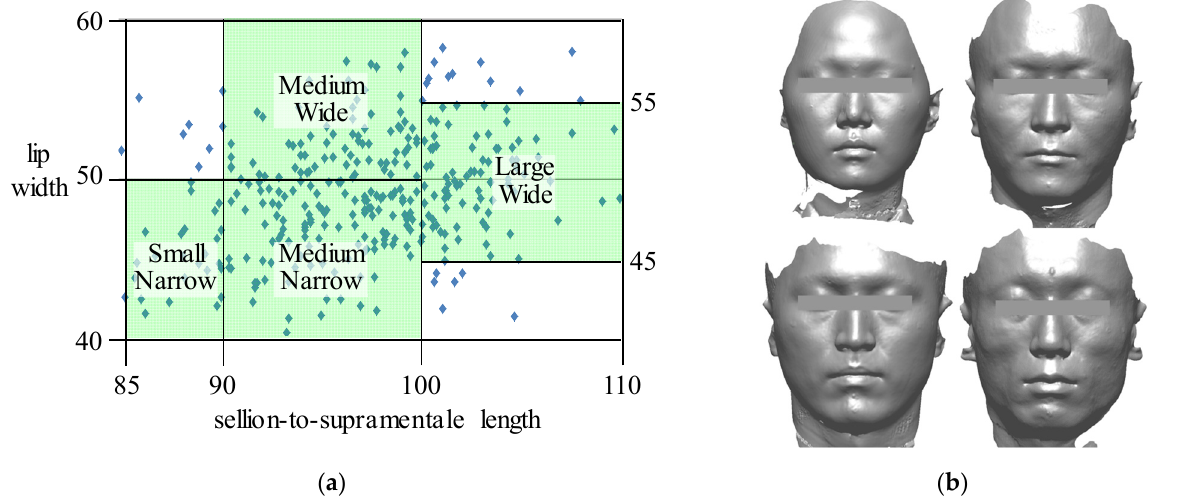
Figure 5. An oxygen mask sizing system and representative face models for Korean Air Force pilots. ( a ) A sizing system of MBU-20/P oxygen mask for Korean Air Force pilots; ( b ) representative face models of the oxygen mask sizing system.